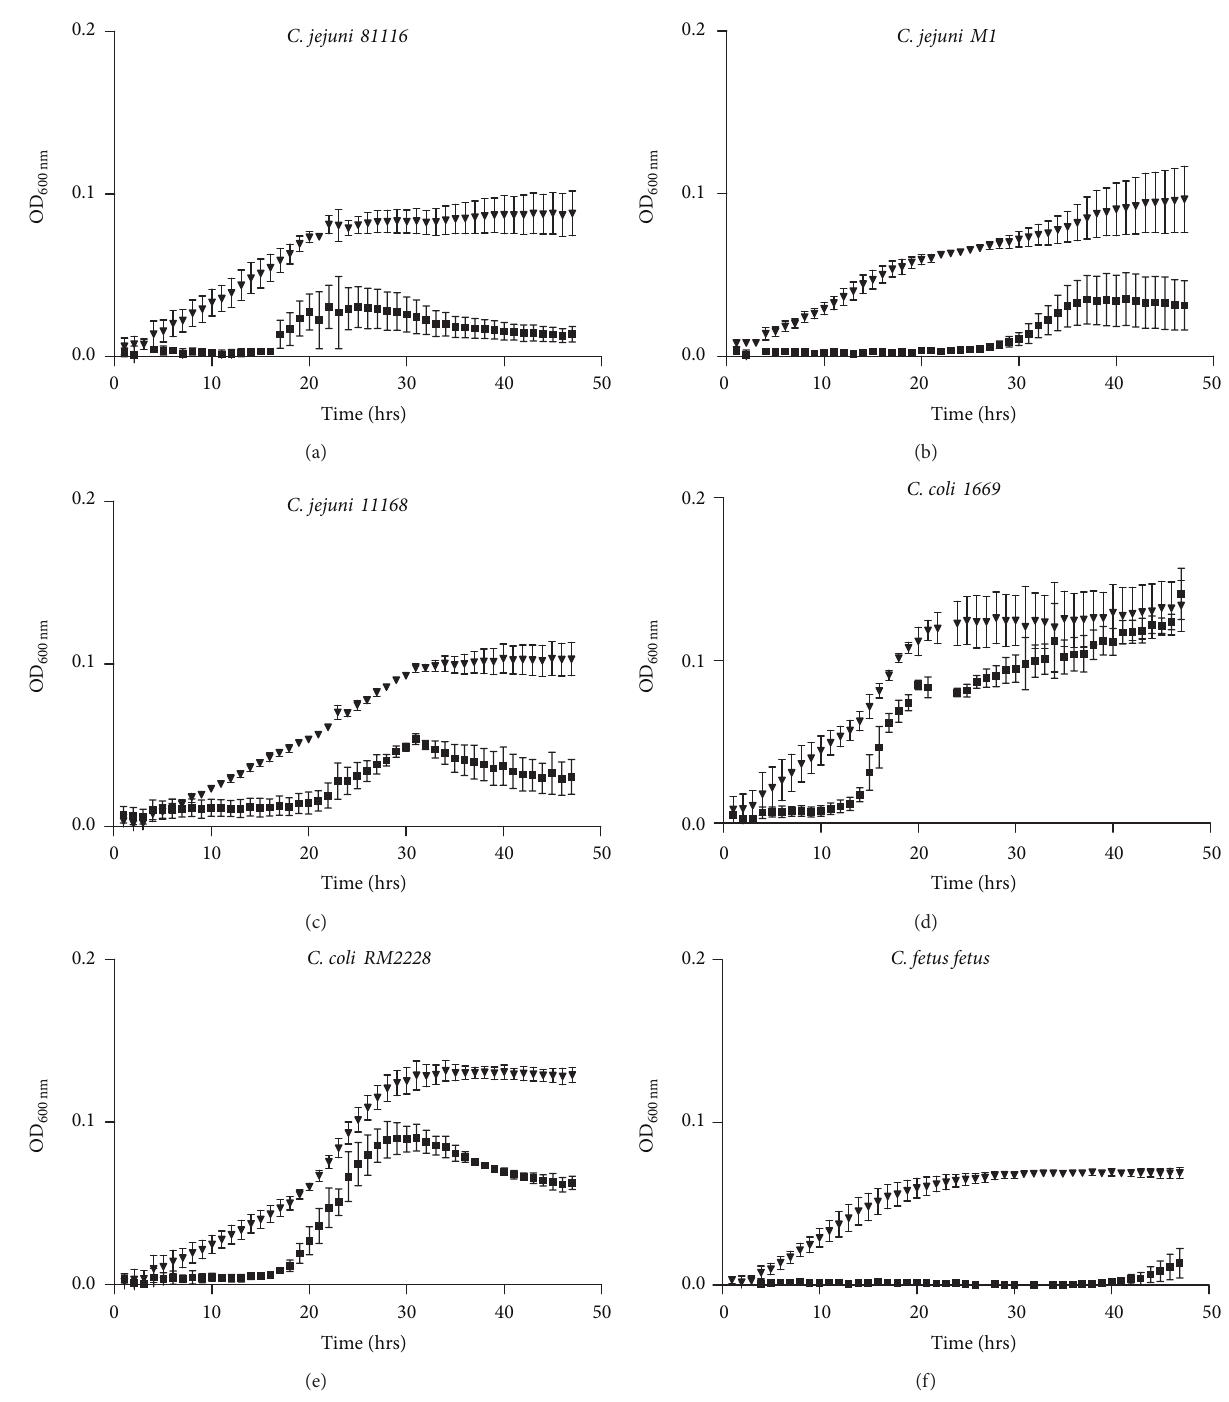
Figure 1: Growth of C. jejuni 81116 (a), C. jejuni M1 (b), C. jejuni 11168 (c), C. coli 1669 (d), C. coli RM2228 (e), and C. fetus fetus (f)species taken over 48 h with readings every hour in the presence and absence of NA at 37 ∘ C. Results are the mean of three separate experiments, and bars represent standard error. The control group values are represented by solid squares and noradrenaline-treated group values are represented by solid triangle